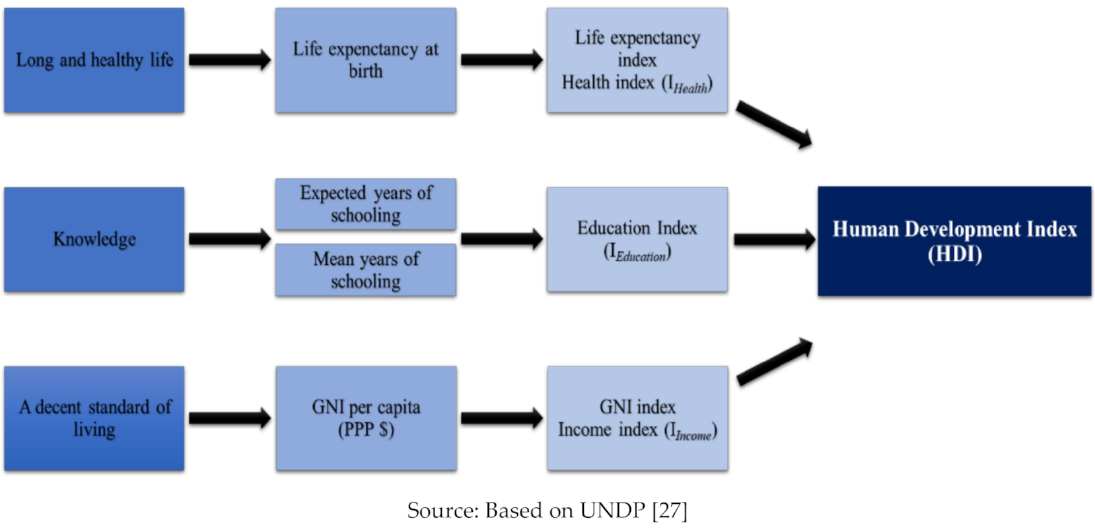
Figure 1. Graphical presentation of the Human Development Index